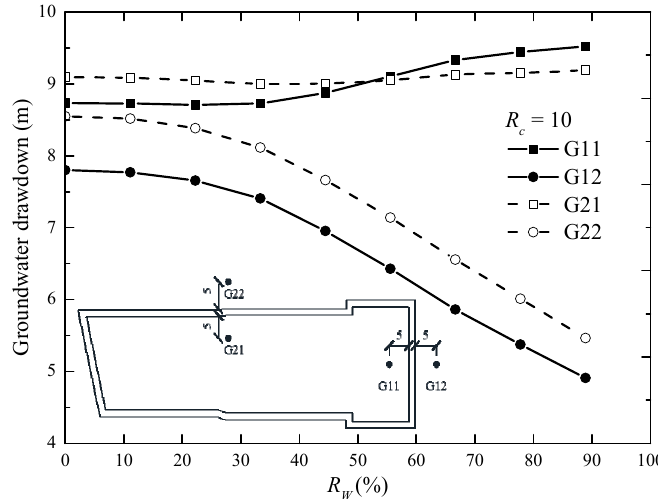
Figure 10. Groundwater drawdown at two sides of diaphragm wall.